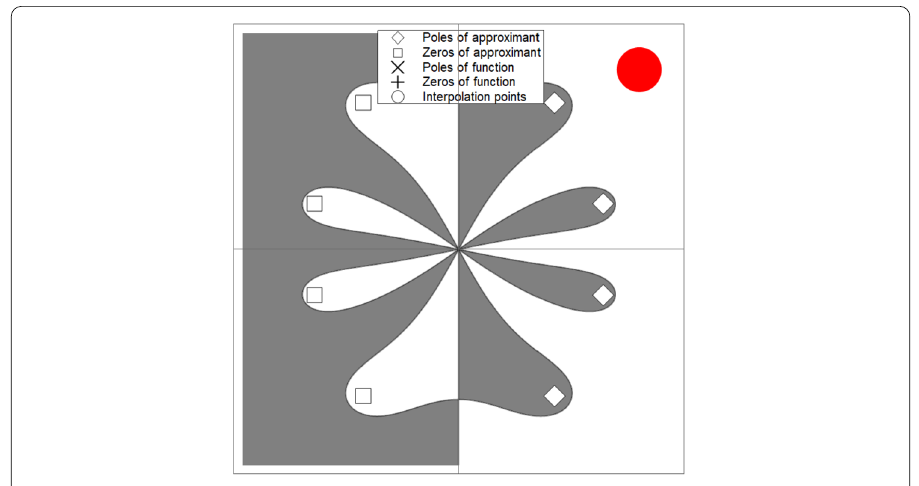
Figure 2 Order stars confirming A -stability of the proposed one-step block method (16) with three intrastep points, including one optimal